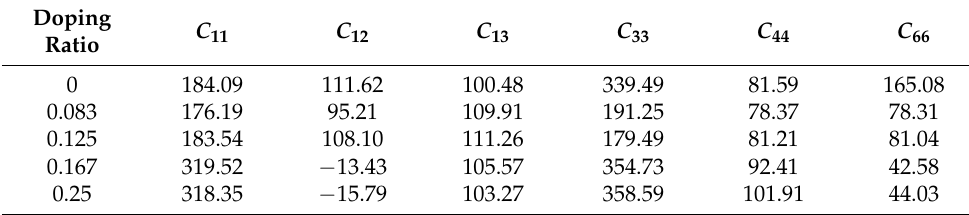
Table 4. Elastic